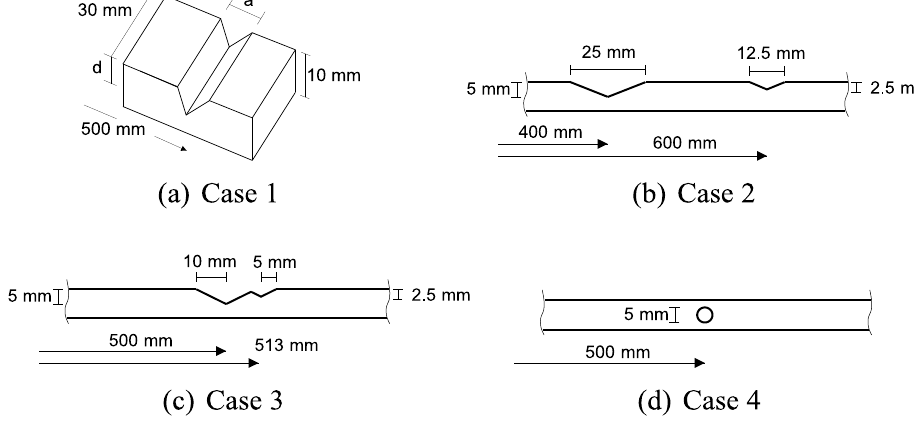
Fig. 1. Four different damage scenarios imposed to the slender